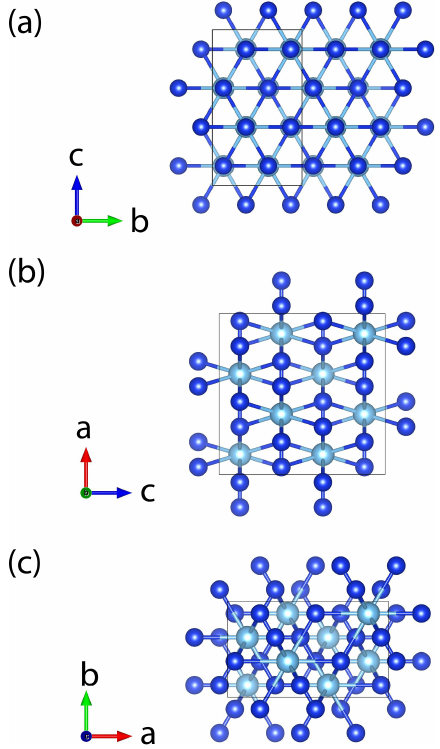
Figure 7. Crystal structure of zhiqinite. (a) View along a; (b) view along b; (c) view along c.